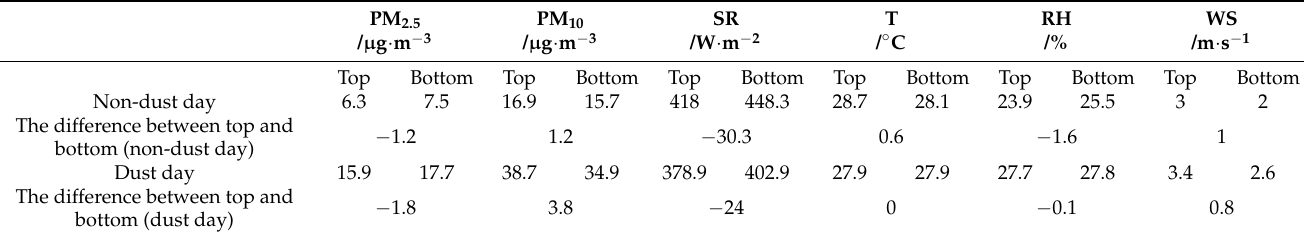
Table 2. Average PM 2.5 concentration, PM 10 concentration, SR, WS, T, and RH at the top and bottom of the dunes on the non-dust and dust days at TZ in the TD.